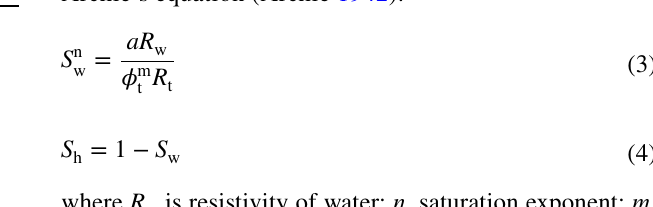
Table 1 Routine core analysis data of Well-C and Well-B Well-C Well-B Depth (m) Perme- ability